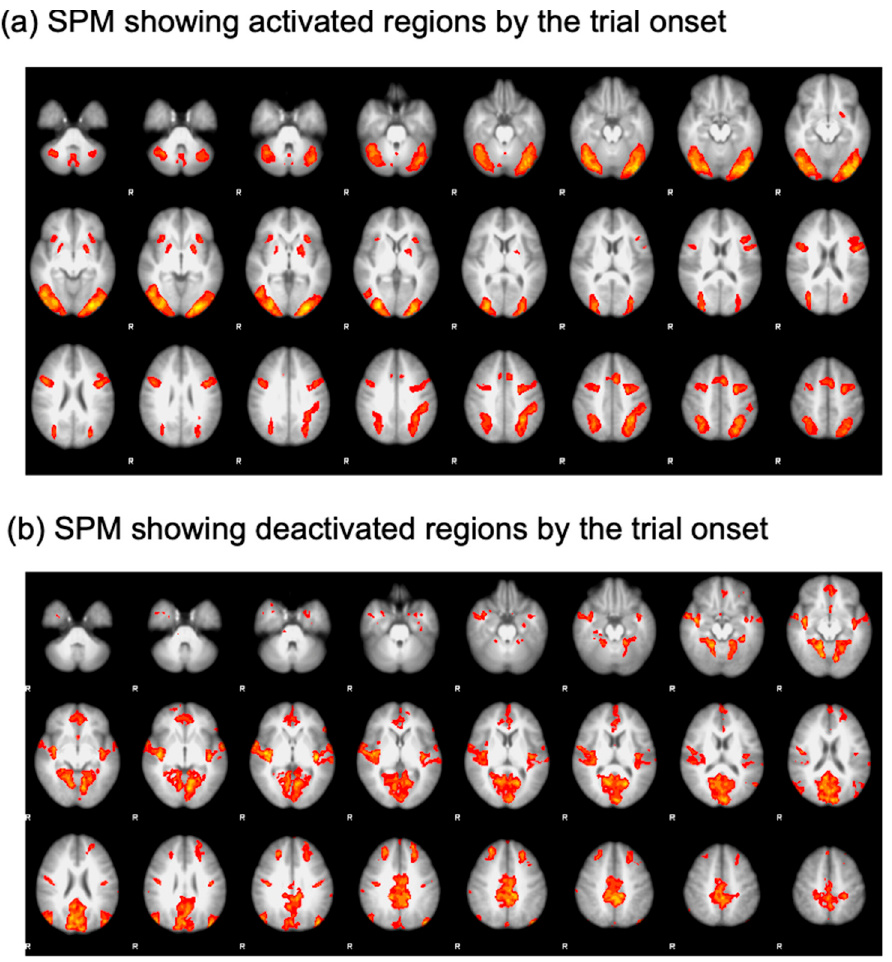
Figure 2. SPM results. ( a ) Regions activated by the trial onset. ( b ) Regions deactivated by the trial onset. Table 1. Coordinates and Z-values of ROIs. DMN—Default Mode Network, MDN—Multiple Demand Network.